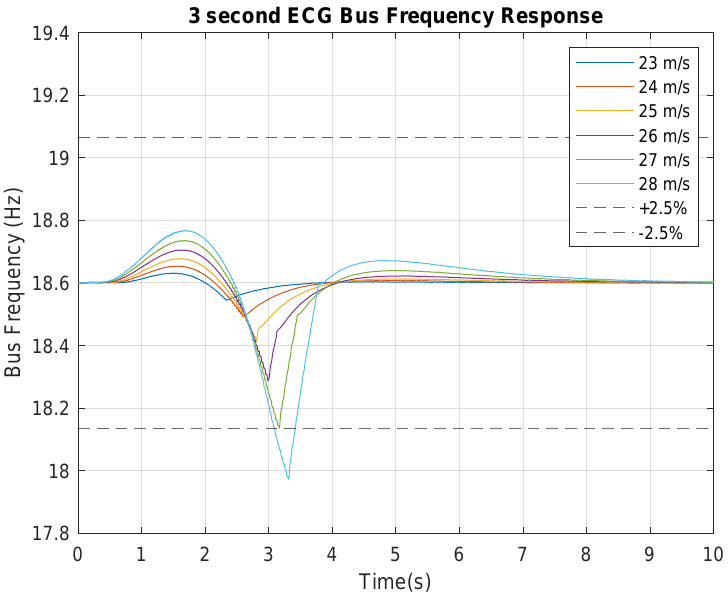
Figure 10. System frequency response to 3 s ECG